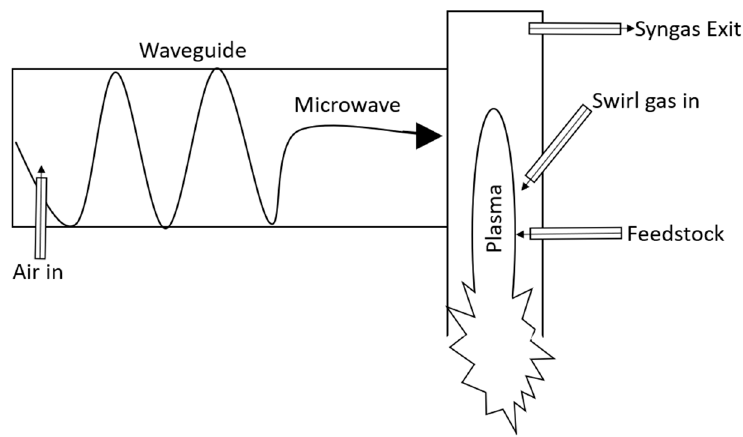
Figure 3. Close-up schematic representation of an EMIPG system reactor.